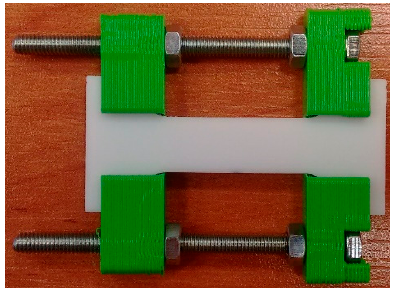
Figure 3. Sample grip for stretching samples and maintaining deformation during measurements: The callipers of the holder were made using a 3-D printer.